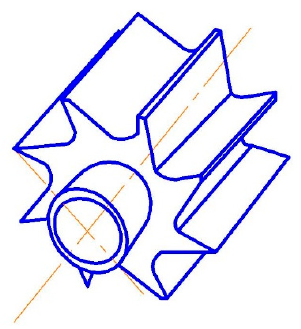
Figure 3. Milling cutting system of the chopper.